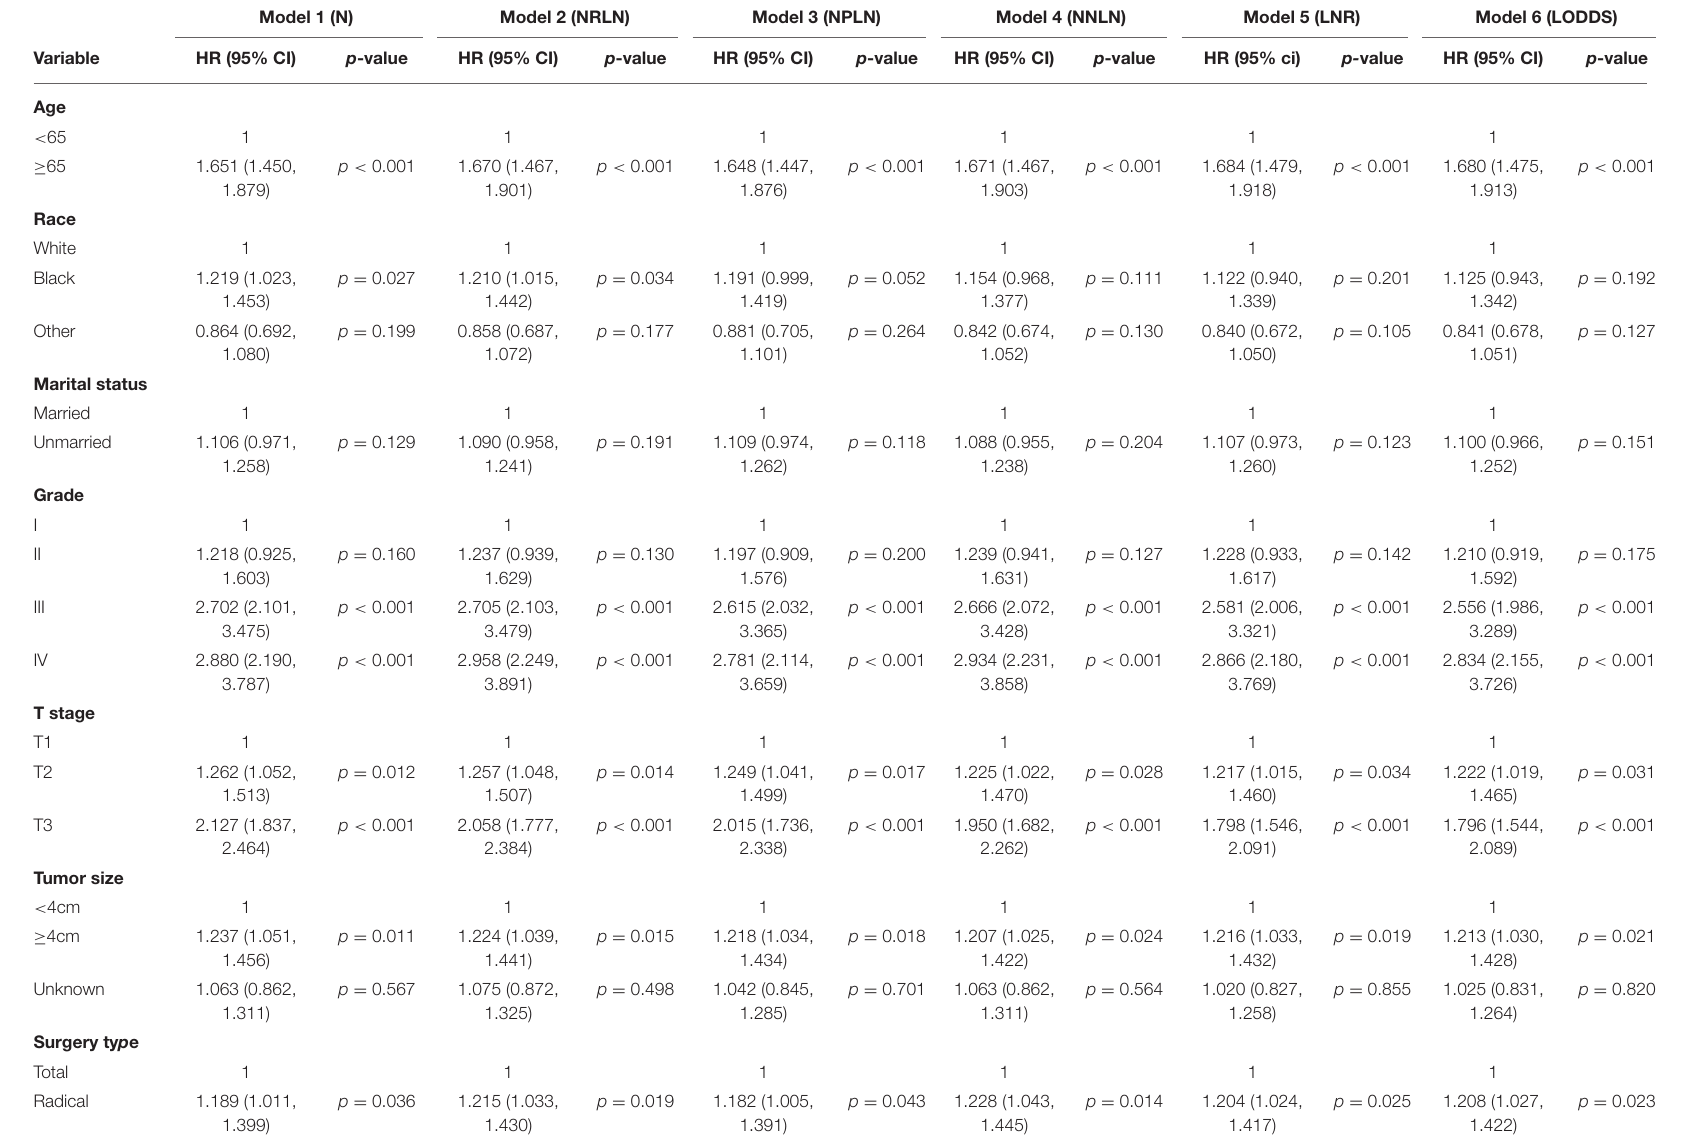
TABLE 2 | Multivariable Cox regression analysis (Models 1–6) of prognostic predictors for